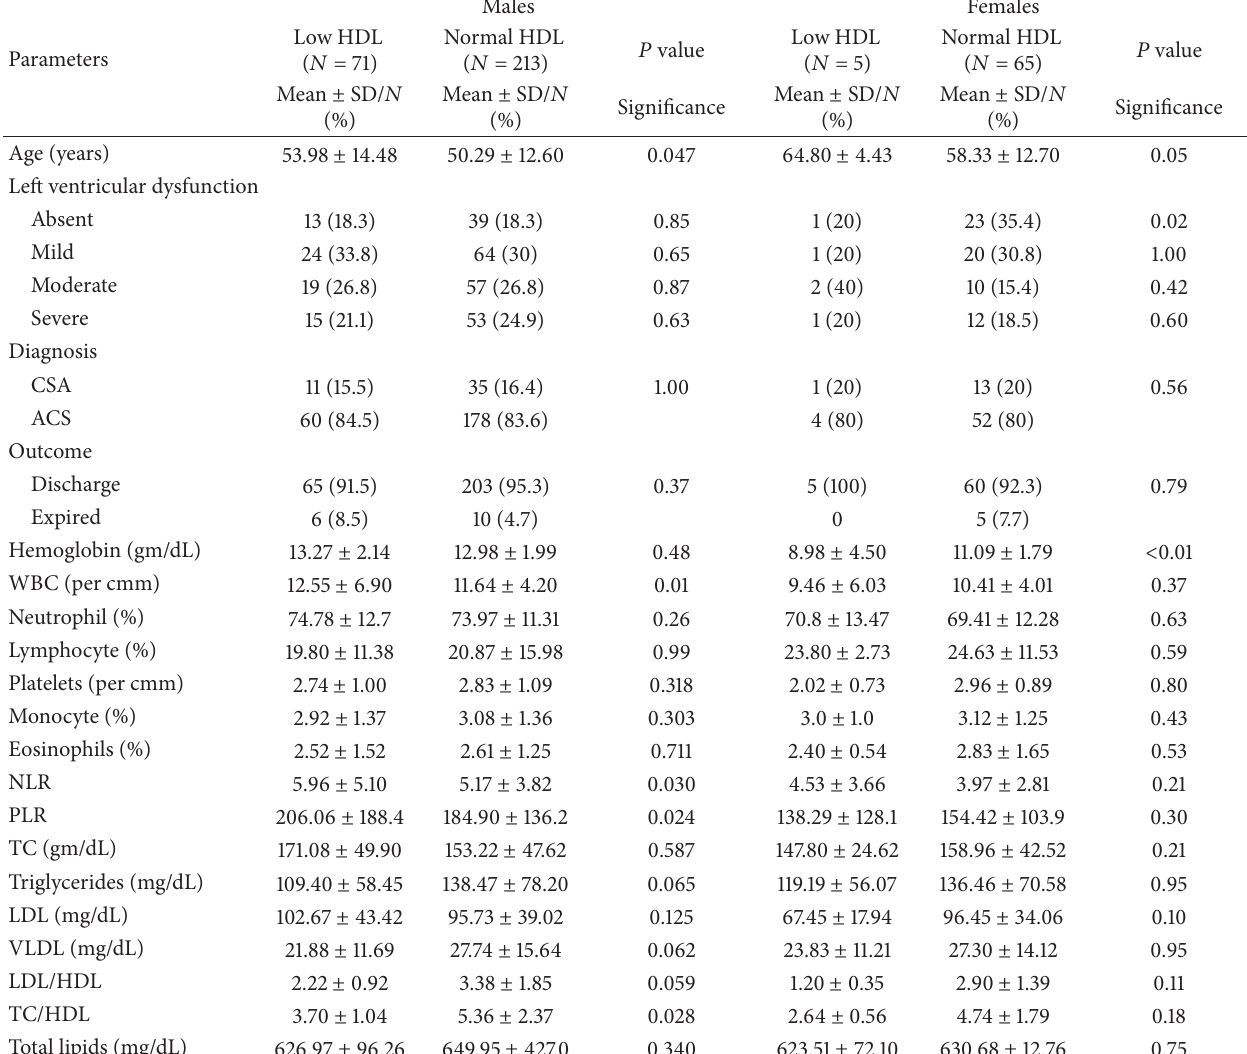
Table 4: Demographic, clinical, and laboratory characteristics according to HDL-C levels in male versus female population.